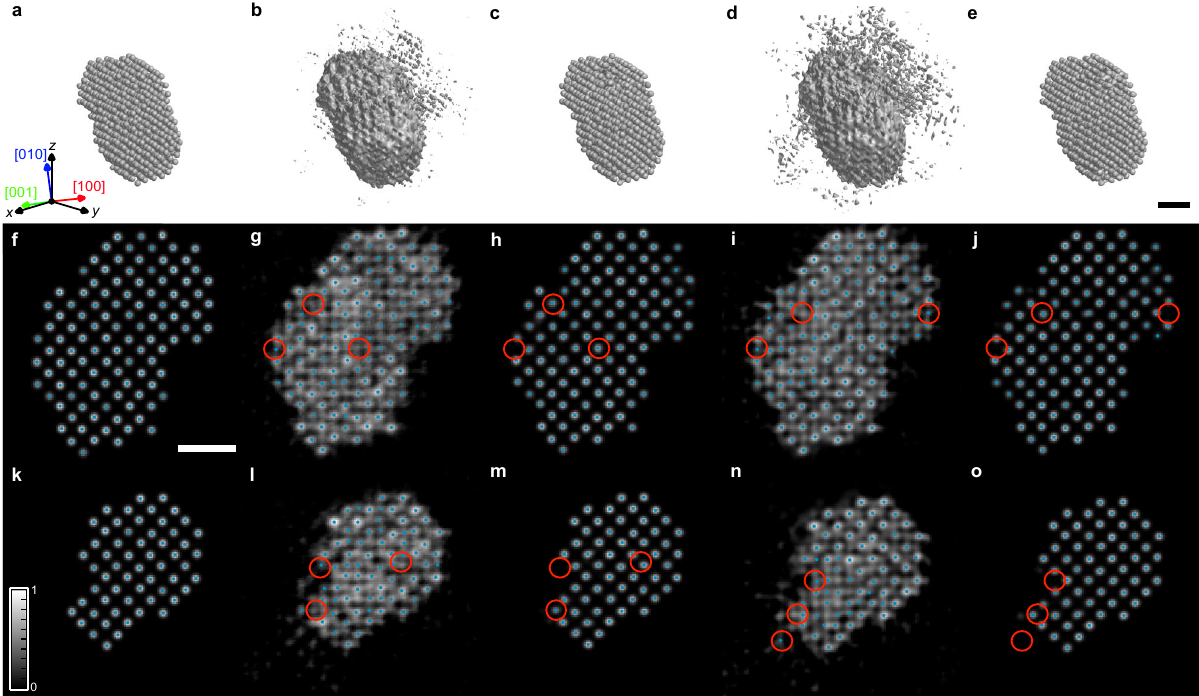
Fig. 2 Effect of the DL augmentation for simulated tomograms. a – e 3D iso-surfaces plotted with 10% iso-surface values (10% of the highest intensity), representing ground truth ( a ), linear tomogram before ( b ) and after the DL augmentation ( c ), PRISM tomogram before ( d ), and after the DL augmentation ( e ). Note that the z direction is the missing wedge direction. f – o 2-Å-thick slices perpendicular to [001] direction, obtained from the 3D tomograms near the center region ( f – j ) and near the surface ( k – o ). Ground truth ( f , k ), linear tomogram before ( g , l ) and after the DL augmentation ( h , m ), PRISM tomogram before ( i , n ) and after the DL augmentation ( j , o ). The grayscale background represents the reconstructed intensity, and blue dots represent the positions of traced atoms. Red circles denote misidenti fi ed atoms before the DL augmentation, which become correctly traced after the DL augmentation. Scale bars, 1